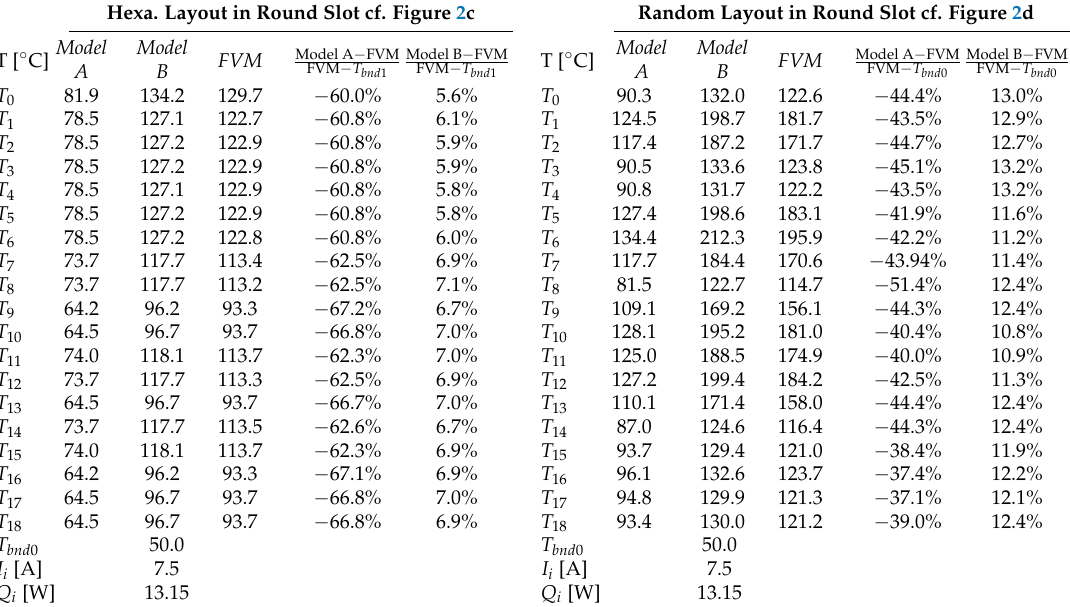
Table 2. Results for hexagonal and random layout in round slot with the model A, B and FVM compared. Corresponding thermal contour in Appendix B respectively in Figure A3 and Figure A4. Hexa. Layout in Round Slot cf. Figure 2c Random Layout in Round Slot cf. Figure 2d